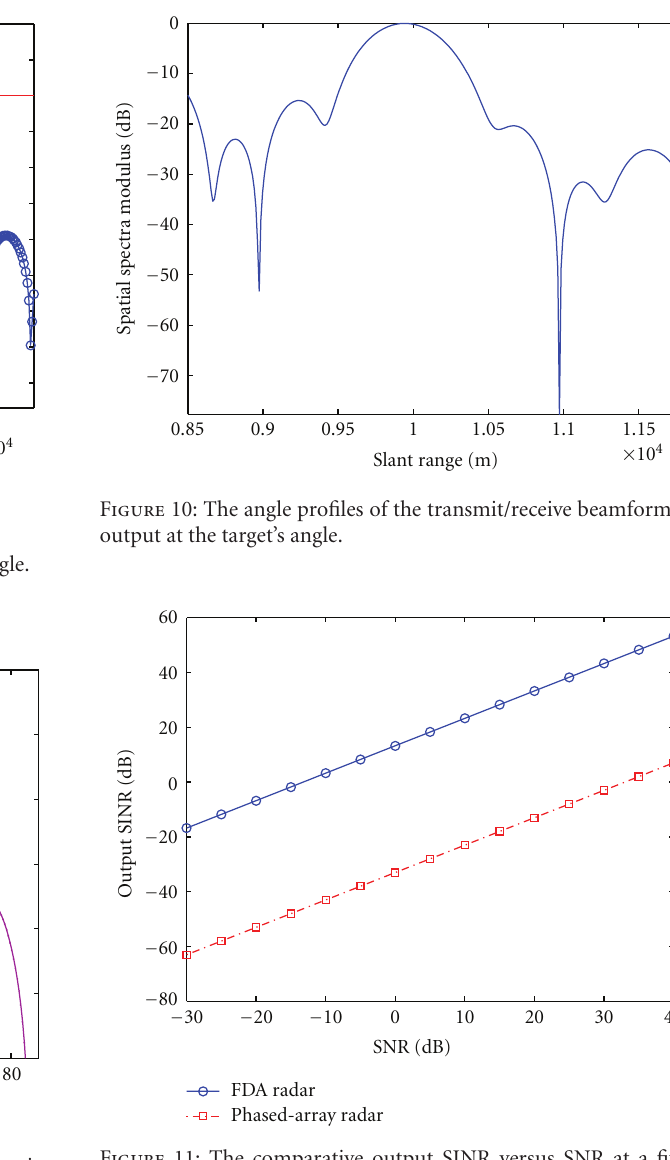
Figure 9: The range profiles of the transmit/receive beamforming output at the target’s range.